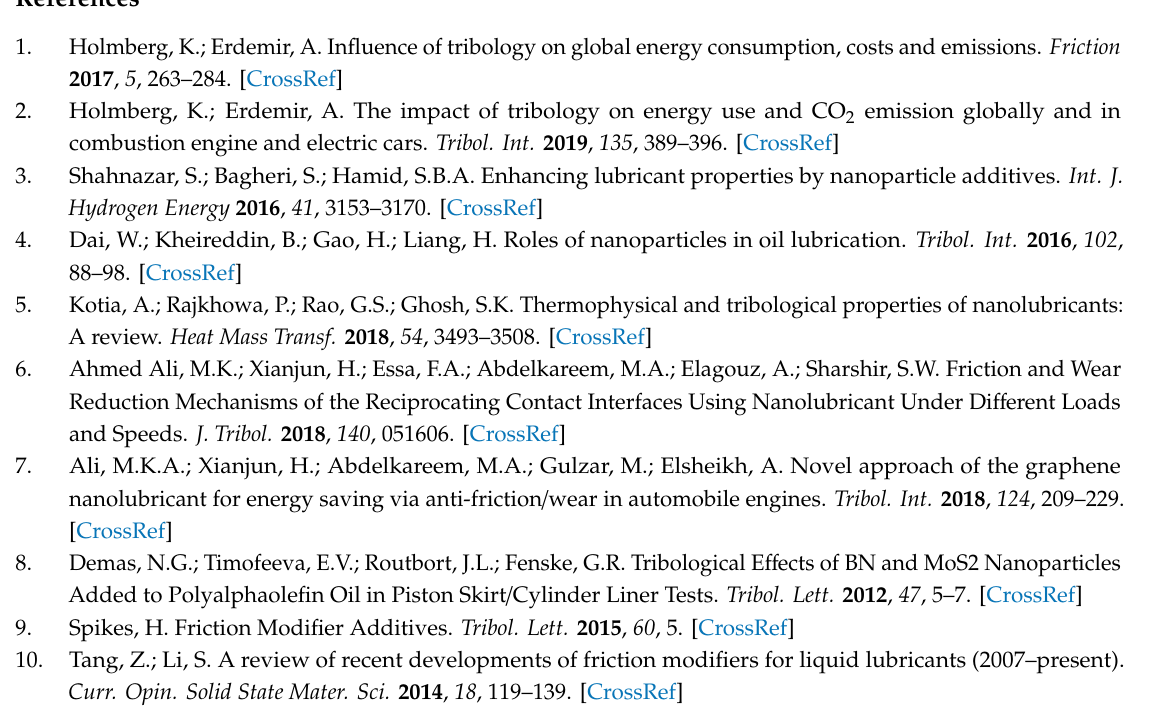
Figure S1: Chemical structure of trimethylolpropane trioleate, Figure S2: Raman spectrum of trimethylolpropane trioleate (TMPTO), Figure S3: Raman spectrum of both Fe 3 O 4 (6.3 nm) and Fe 3 O 4 (10 nm) nanoparticles coated with oleic acid, Figure S4. Raman spectrum of Nd alloy (19 nm) nanoparticles coated with oleic acid. Table